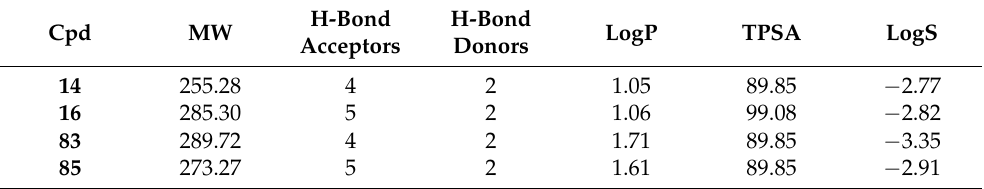
Table 5. Predicted ADME parameters: Molecular Weight (MW); Number of H-bond Acceptors and Donors; Octanol/Water Partition Coefficient (logP); Topological Polar Surface Area in A2 (TPSA); and Water Solubility